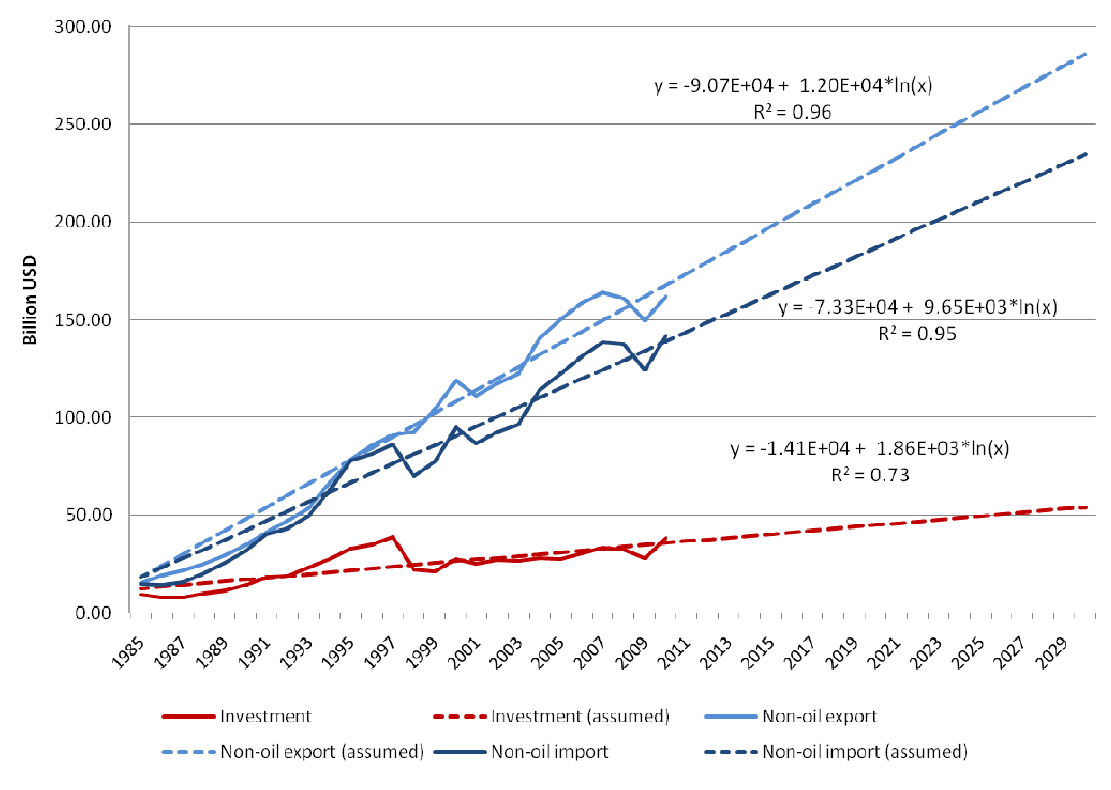
Figure 11. Assumed behaviors (dashed lines) of Investment, Non-oil export and Non-oil import variables and their historical data (solid lines). (Source: